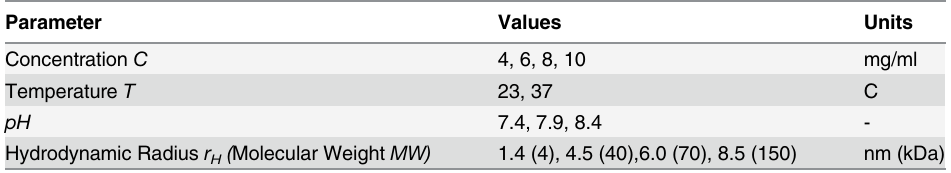
Table 1. Fabrication parameters varied in